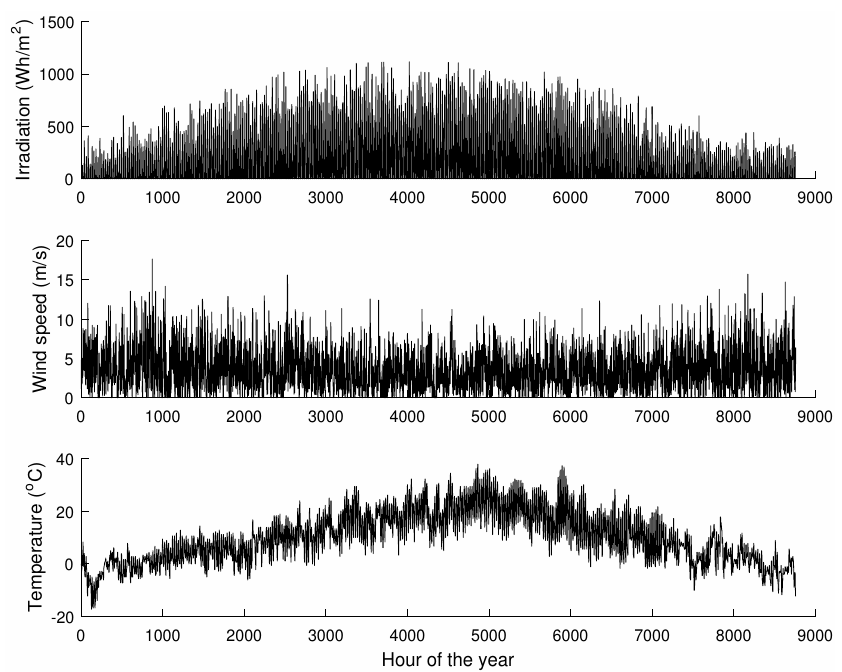
Figure 8. Hourly mean values of meteorological conditions.